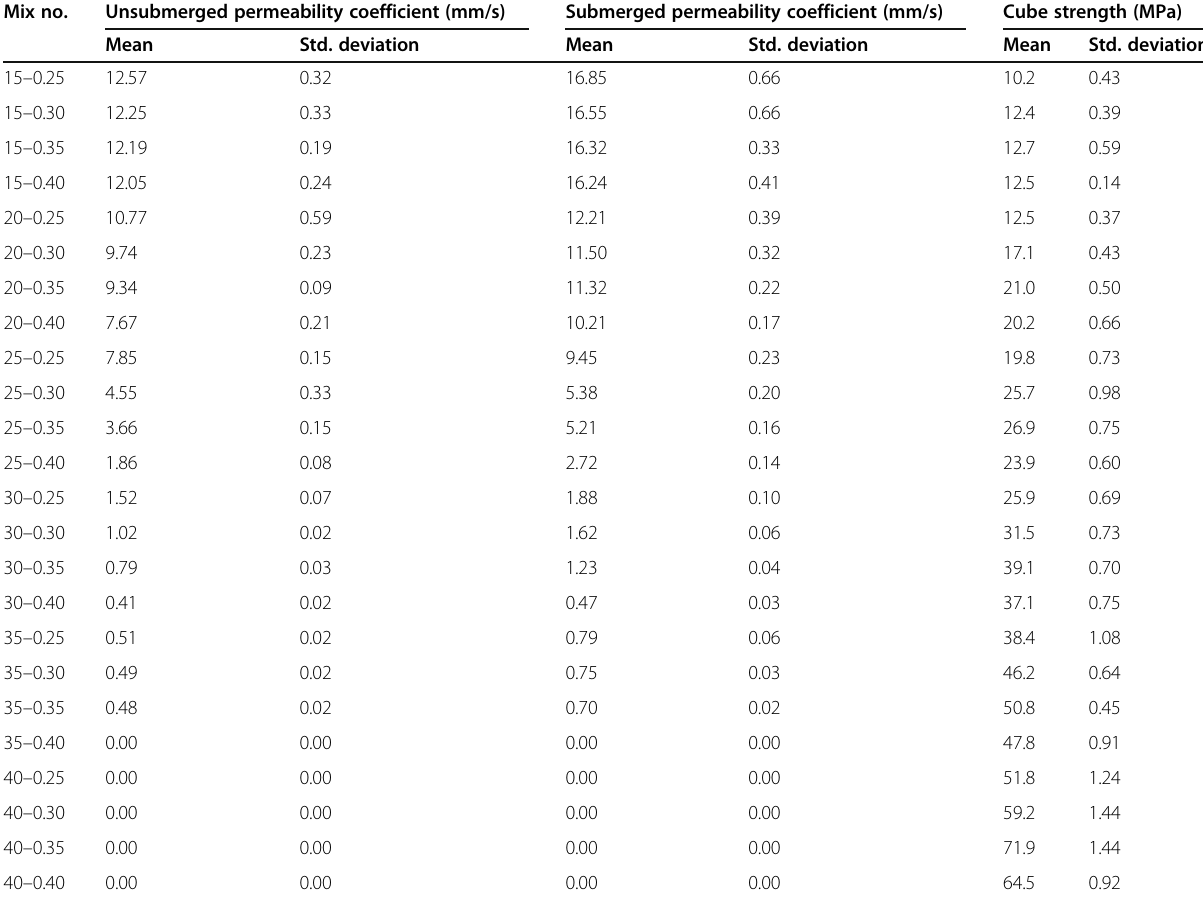
Table 4 Test results